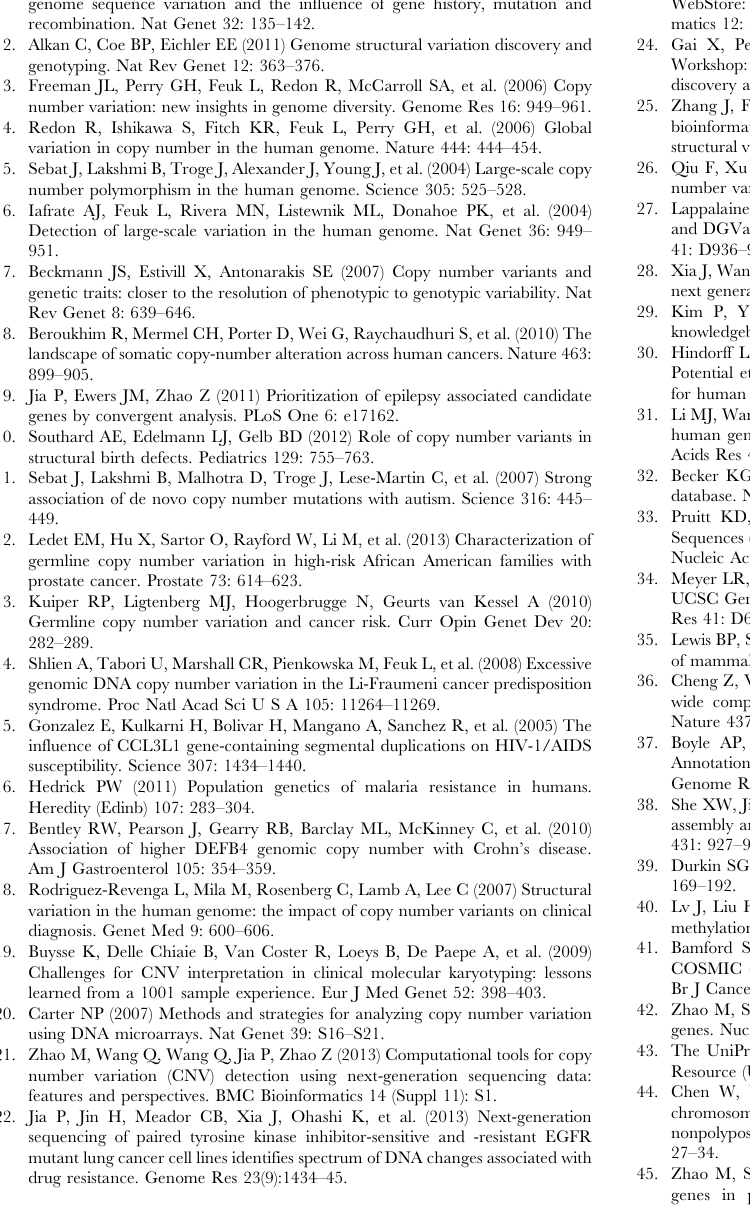
Table S1 The annotation results for the top ten